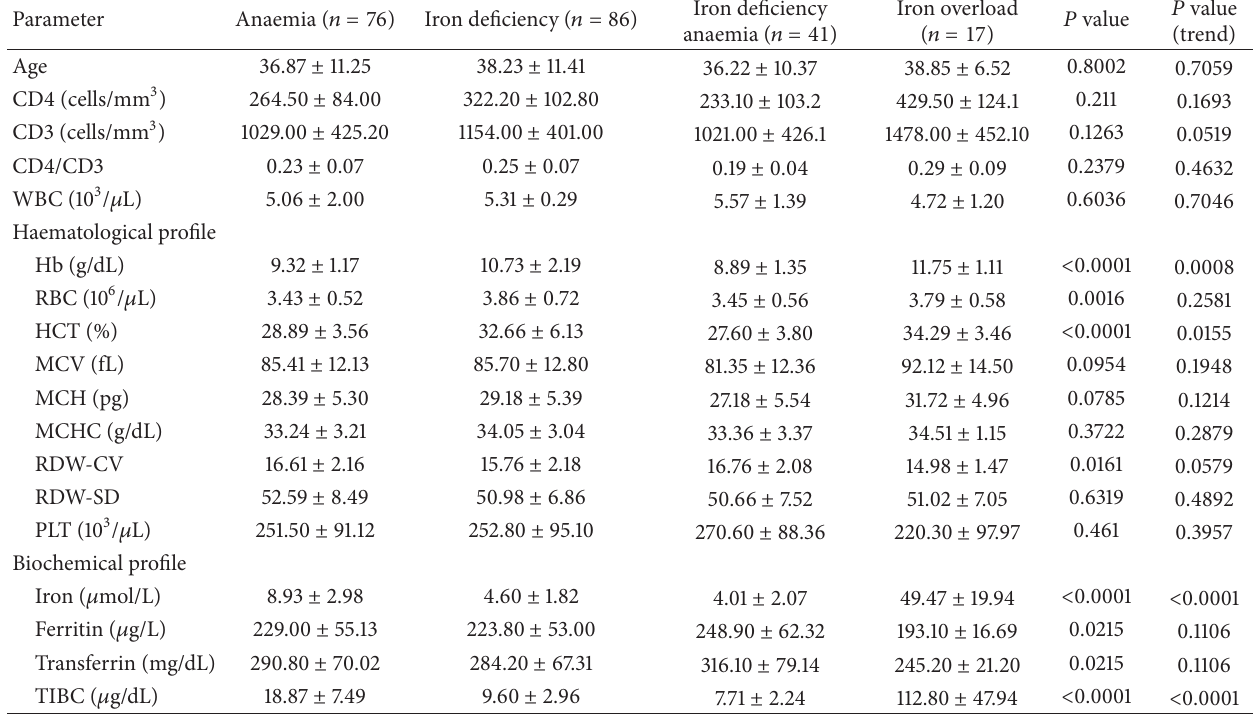
Table 6: Immunological, haematological, and biochemical profiles of the population under study stratified by iron status. Parameter